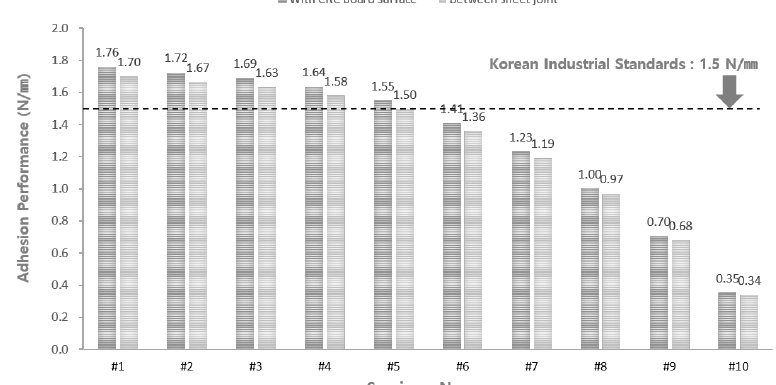
Figure 8. Adhesion performance test result of the HCl-treated sample.